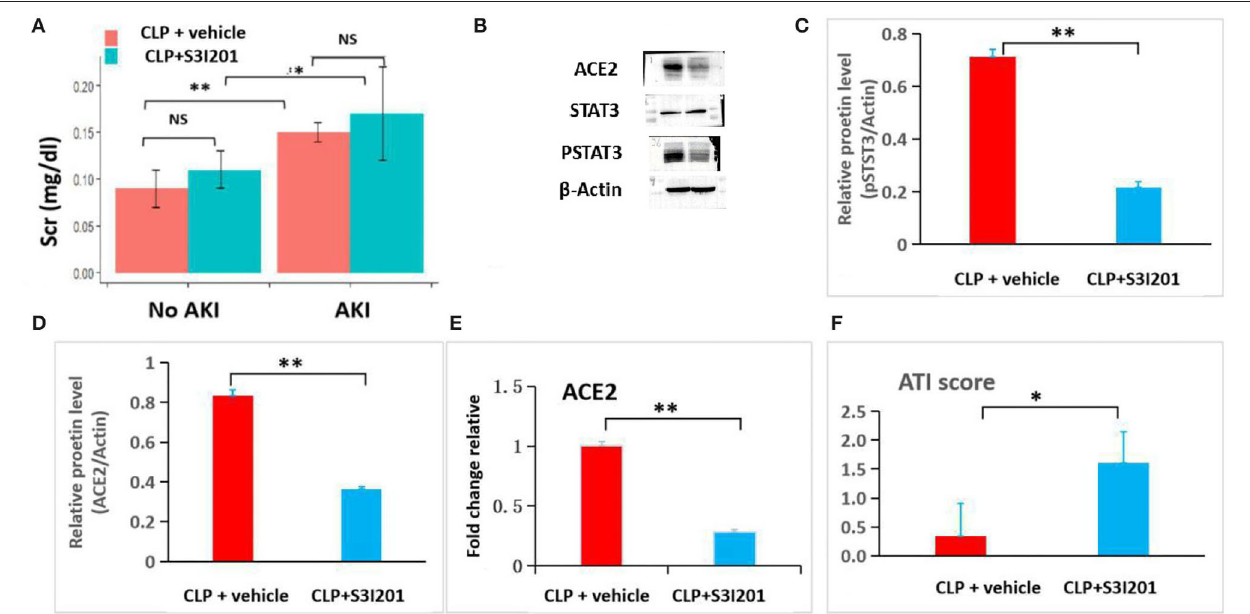
FIGURE 6 | S3I201 intervention experiment in CLP mice. (A) Scr had significant increases in CLP with vehicle ( n = 7) and S3I201 ( n = 5) AKI mice compared with CLP with vehicle ( n = 7) and S3I201 ( n = 5) noAKI mice. (B) Western blot analyses of ACE2, STAT3 and pSTAT3 levels in renal cortex tissues of CLP with vehicle and S3I201 AKI mice. (C) Relative pSTAT3 levels in CLP with vehicle and S3I201 AKI mice. (D) Relative ACE2 levels in CLP with vehicle and S3I201 AKI mice. (E) ACE2 mRNA expression in CLP with vehicle and S3I201 AKI mice determined by RT-PCT. (F) Acute tubular injury scores in CLP with vehicle and S3I201 AKI mice. ATI, acute tubular injury. *, p < 0.05; **, p <